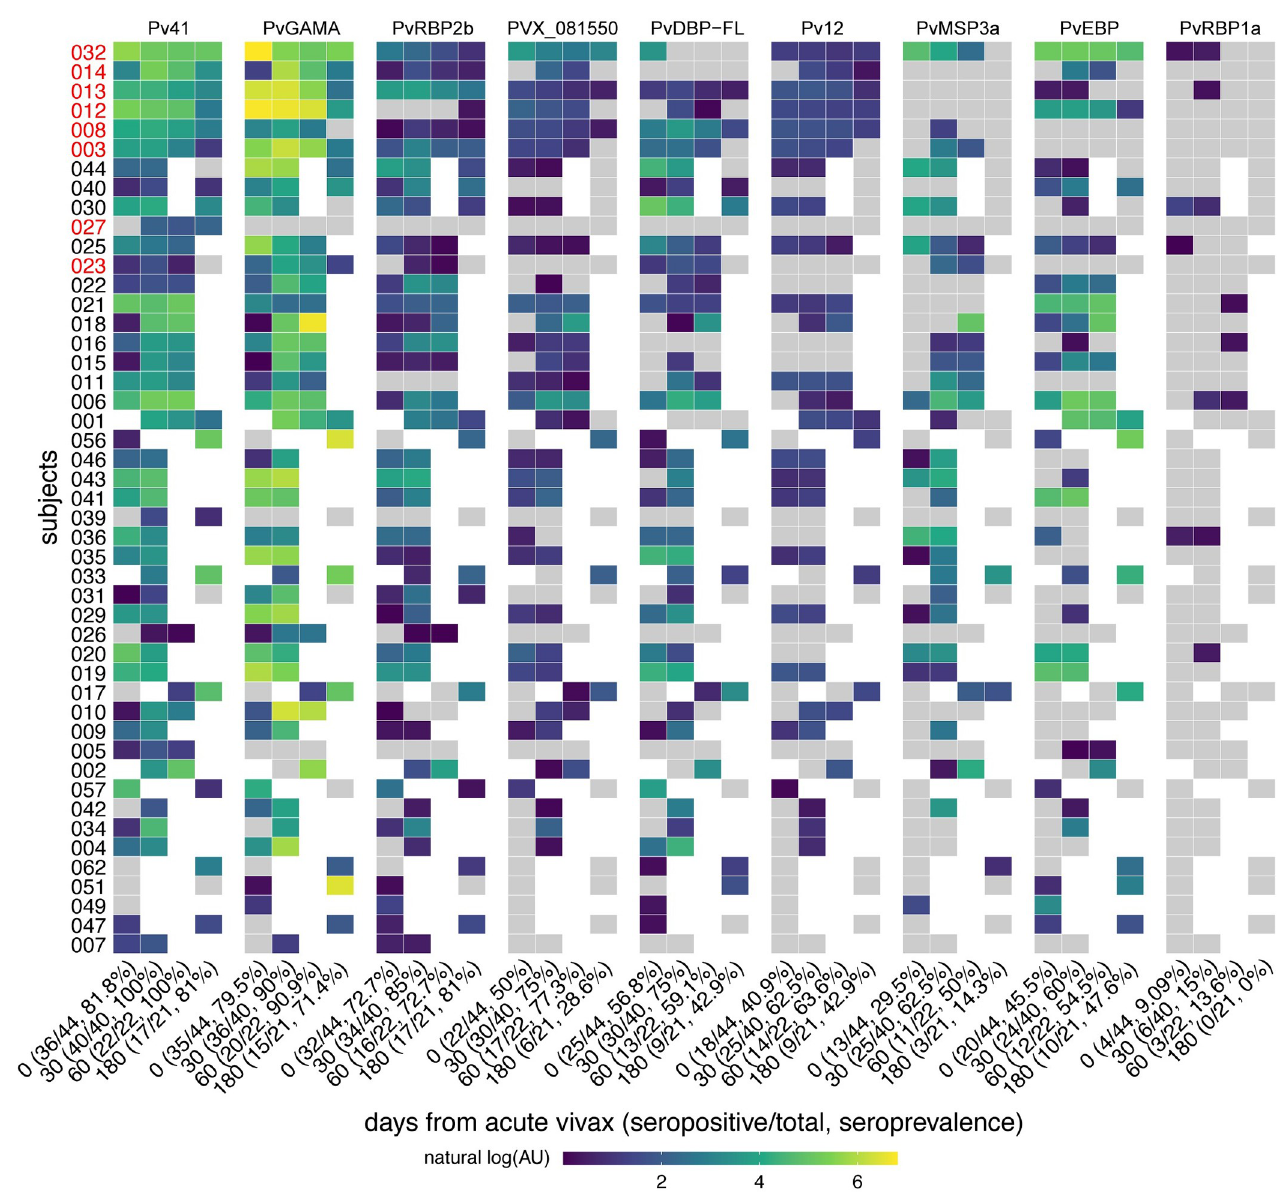
Fig 2. Seropositivity by antigen by time point. For each antigen, a seropositivity cut-off was set as the mean reactivity of malaria-na ï ve North American control samples + 2 standard deviations. Reactivities were converted to arbitrary units (AU) where by fluorescence intensity for each antigen was divided by its respective seropositivity cut-off. Antigens are ordered from left to right by seroprevalence, and columns within each antigen are ordered by seroprevalence. Rows, representing subjects, are ordered from top to bottom by overall seropositivity followed by completeness of longitudinal samples. Gray tiles represent samples that were seronegative (AU � 1). Blank tiles are missing samples. Red text denotes subjects with data at all four time